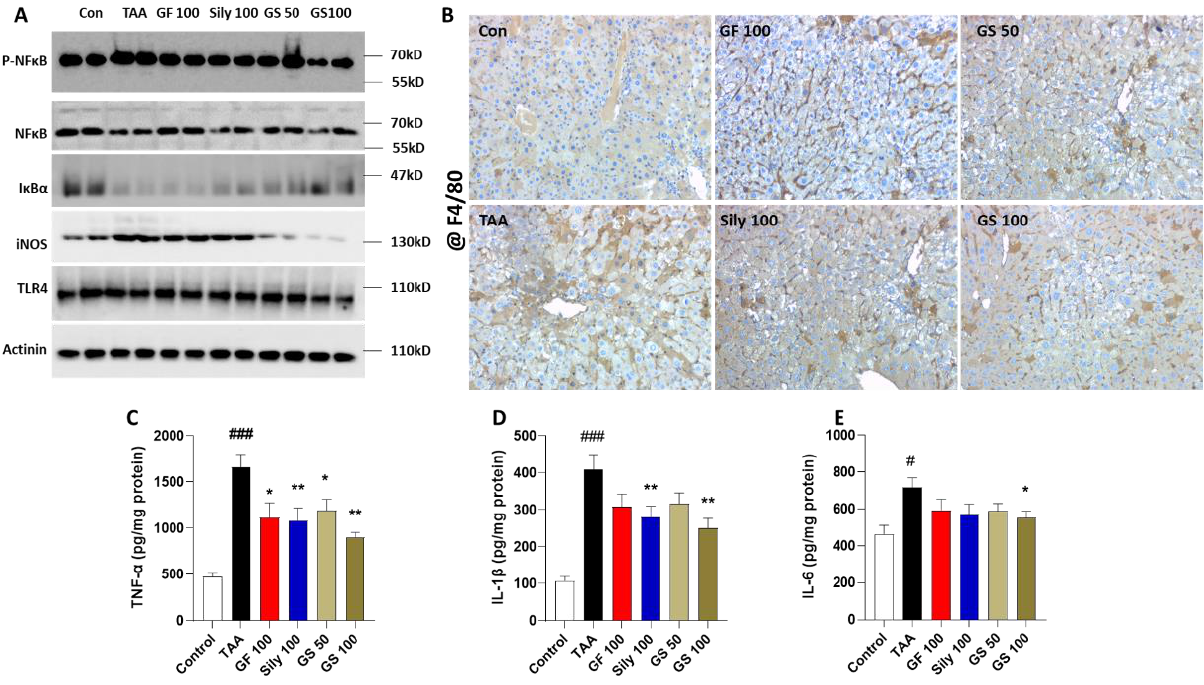
Figure 4. Anti-hepatic inflammation effects of GS by regulation of pro-inflammatory response. ( A ) Western blot analysis of the inflammation-related proteins. ( B ) Representative images of F4/80 in the liver tissue. ( C ) Hepatic protein levels of TNF- α , ( D ) IL-1 β , and ( E ) IL-6. Data were expressed by mean ± S.E.M. # p < 0.05 and ### p < 0.001 for Control vs. TAA. * p < 0.05 and ** p < 0.01 for TAA vs. drug treatments ( n = 4 for IHC analysis, n = 6–8 for biochemistry analysis, n = 4 for Western blot analysis). Images were captured by light microscopy conditions (100× magnifications).